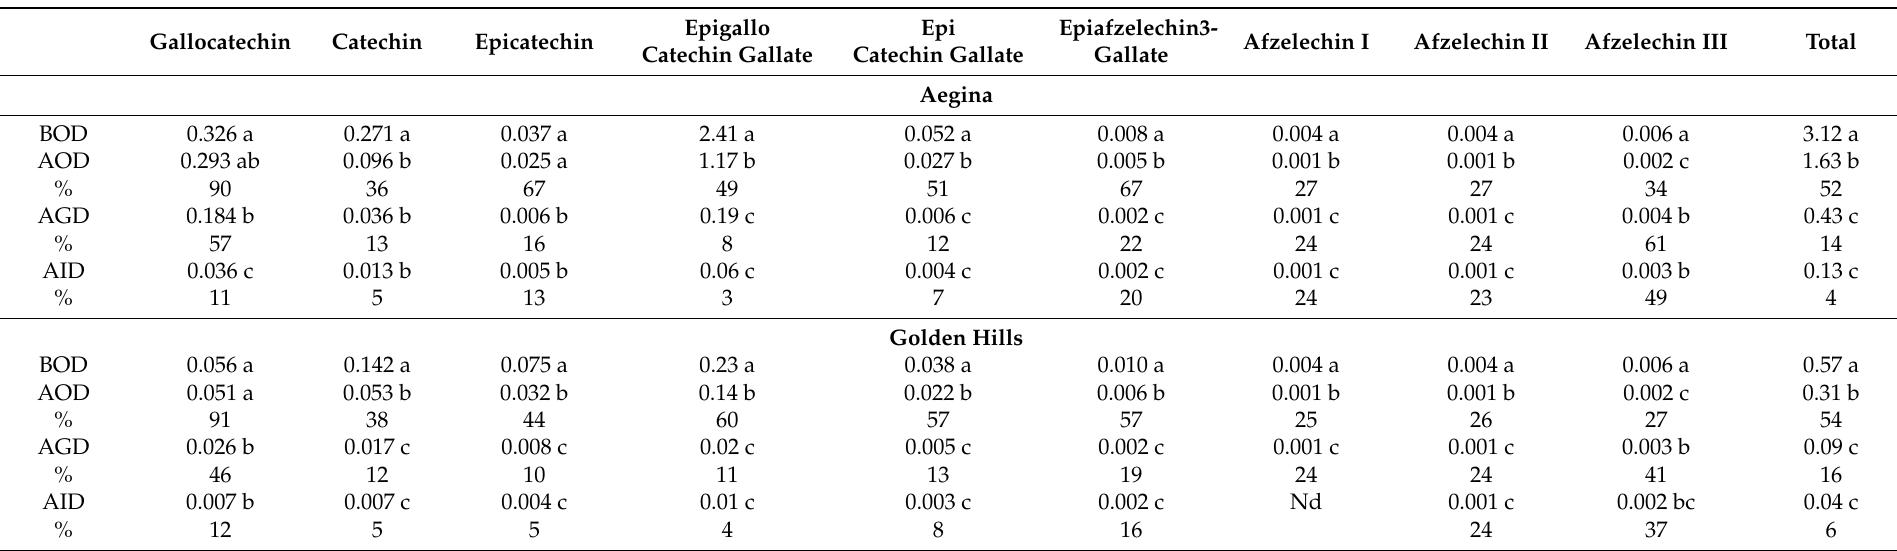
Table 3. Flavan-3-ol group determined in pistachios before and after oral, gastric and intestinal in vitro digestion (nmol/g